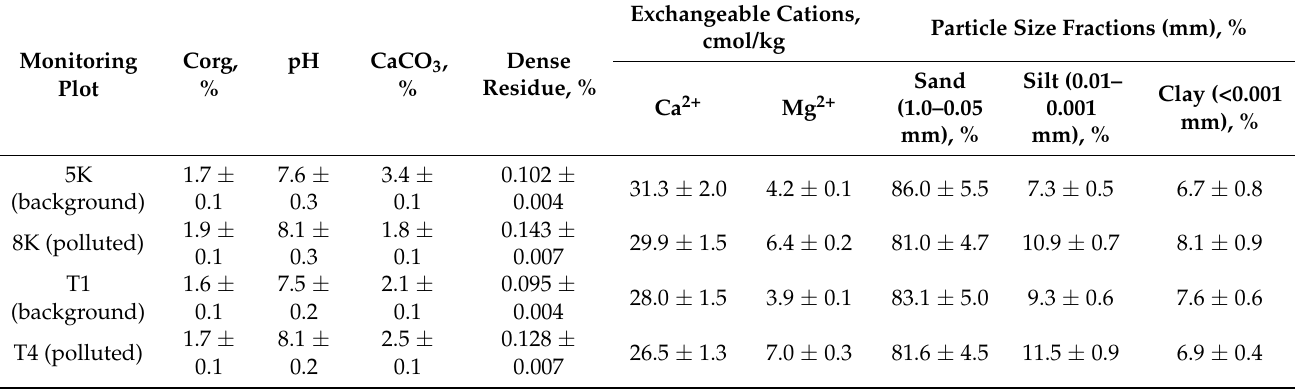
Table A1. Physical and chemical properties of fluvisols at the monitoring plots on the sea edge of the Don River delta, 0–20 cm